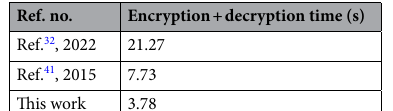
Table 13. Comparing the execution times for an image of size 256